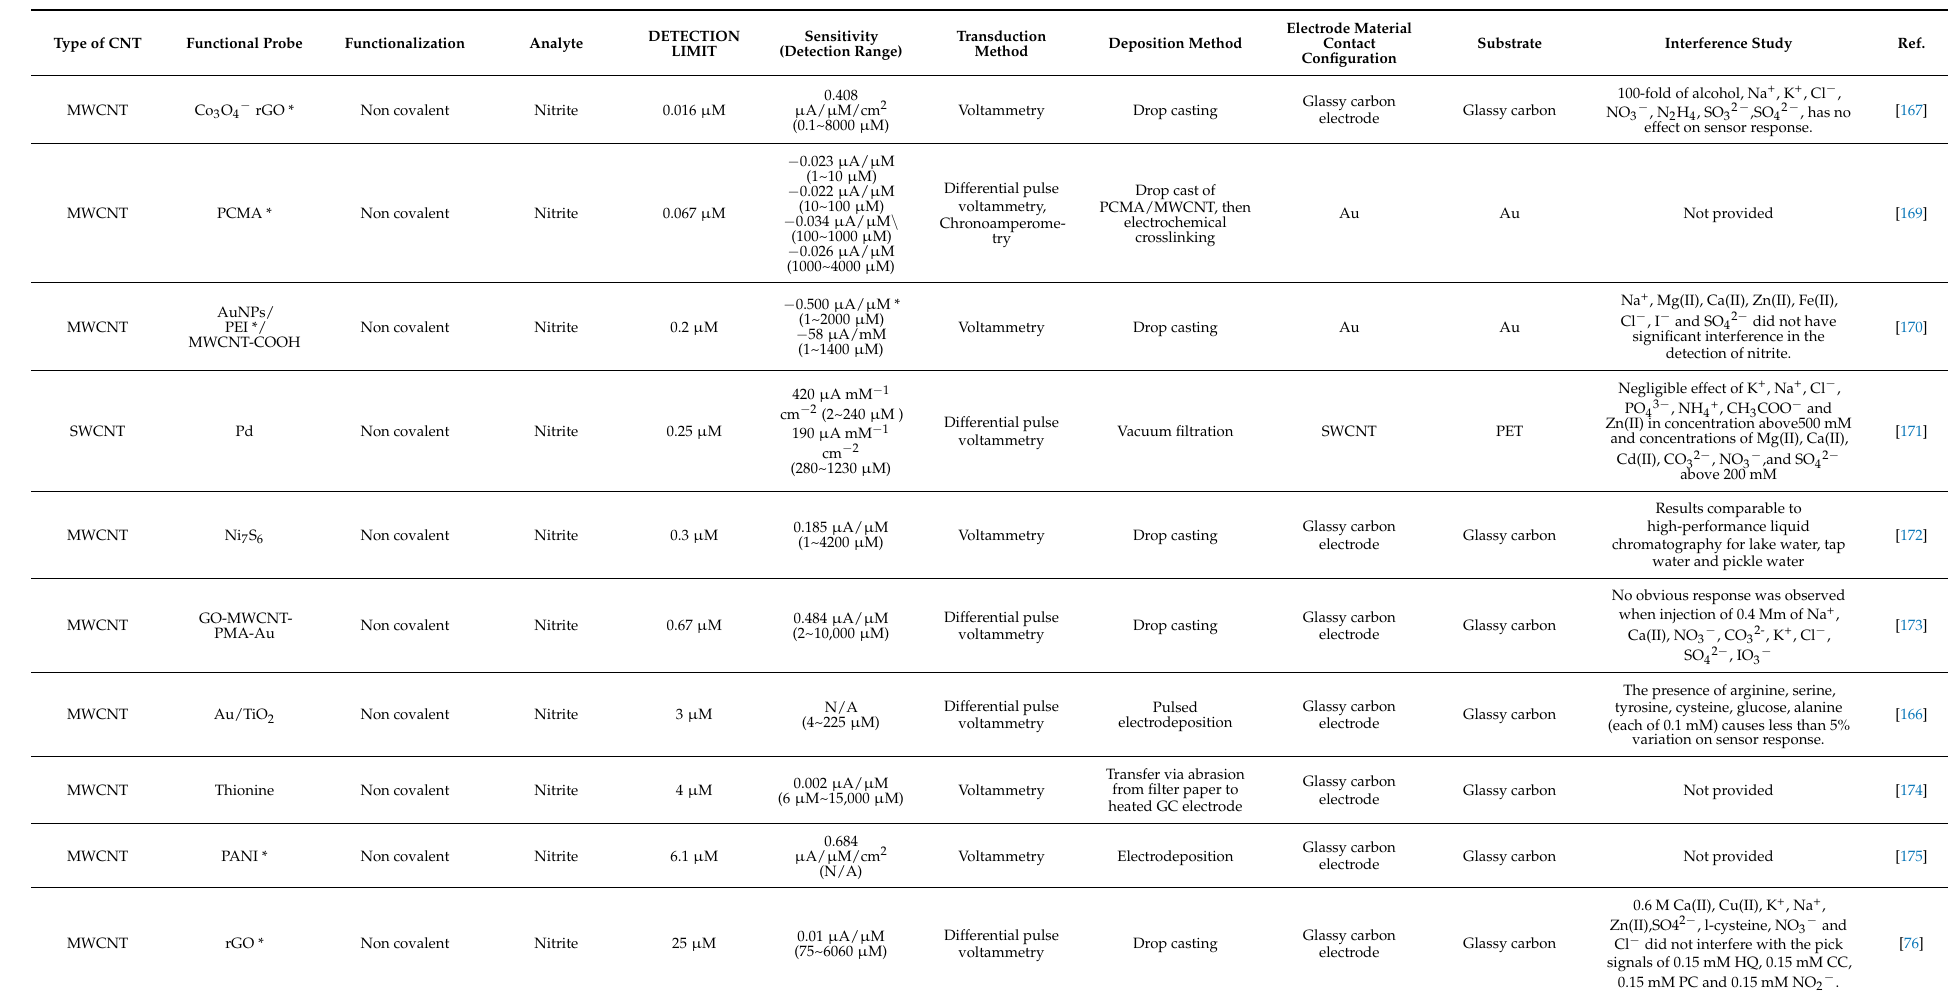
Table 11. CNT-based nitrogen sensors for water quality monitoring, sorted by detection